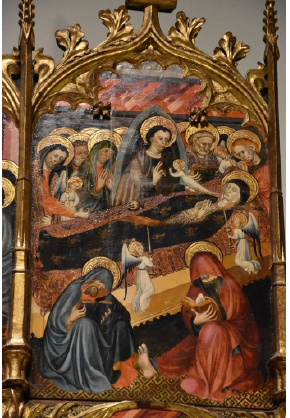
Figure 5. Jaume Cirera, “Dormition of the Virgin”. Detail from Altarpiece of Saint Michael and Saint